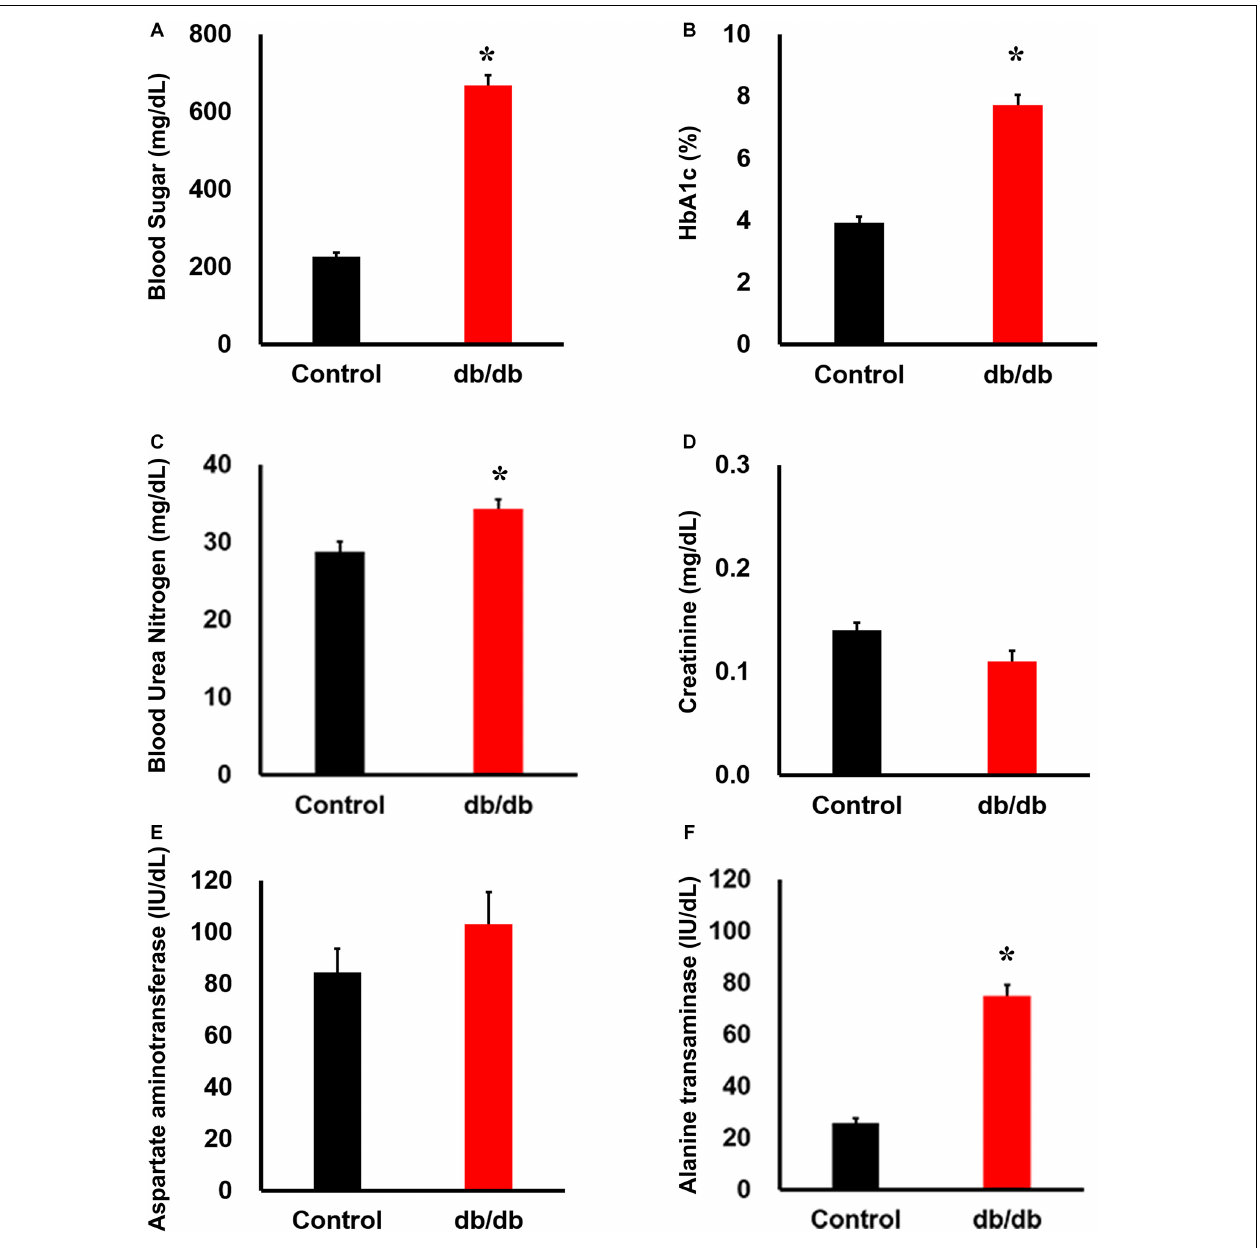
FIGURE 1 | Phenotype of db/db mice under normal conditions. Serum (A) blood sugar, (B) HbA1c, (C) blood urea nitrogen, (D) creatinine, (E) aspartate aminotransferase, and (F) alanine transferase concentration: blood sugar, HbA1c, blood urea nitrogen, and alanine transferase concentrations were significantly higher in db/db mice ( n = 6) than in the wild-type mice ( n = 6). *, P < 0.05 vs. wild type.